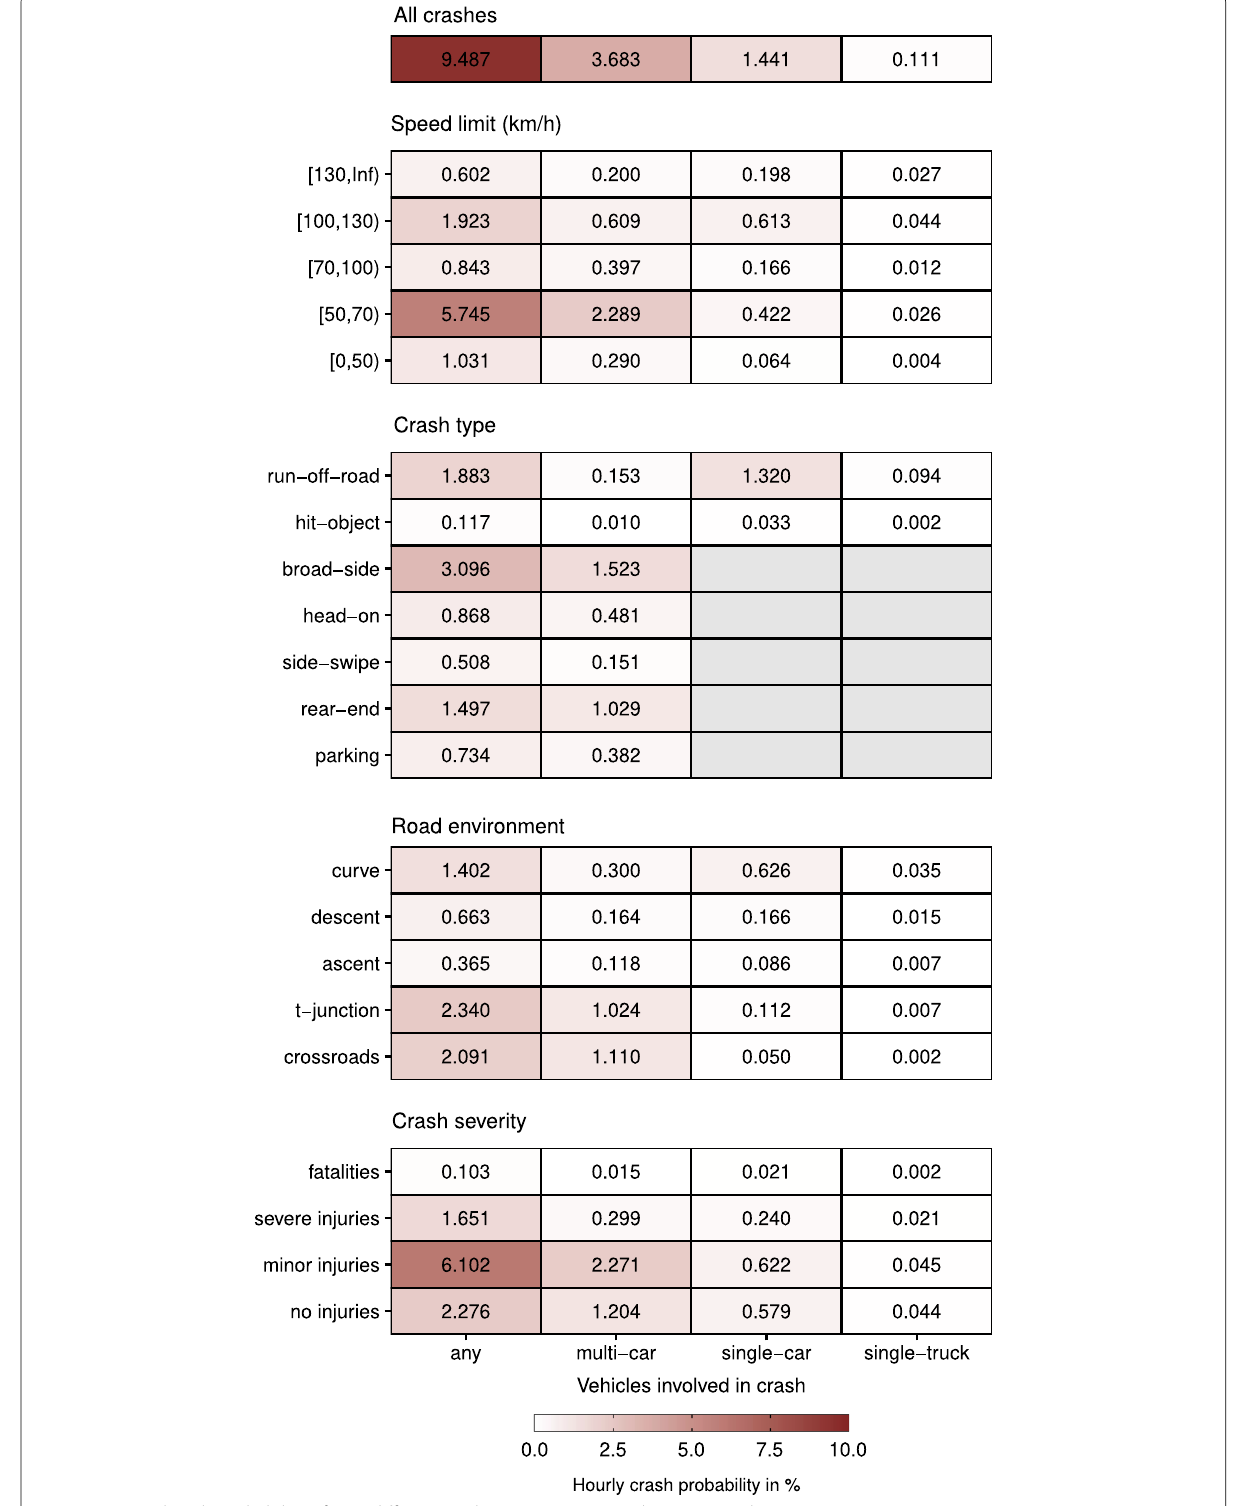
Fig. 1 Average hourly probabilities for 78 different crash types in German administrative